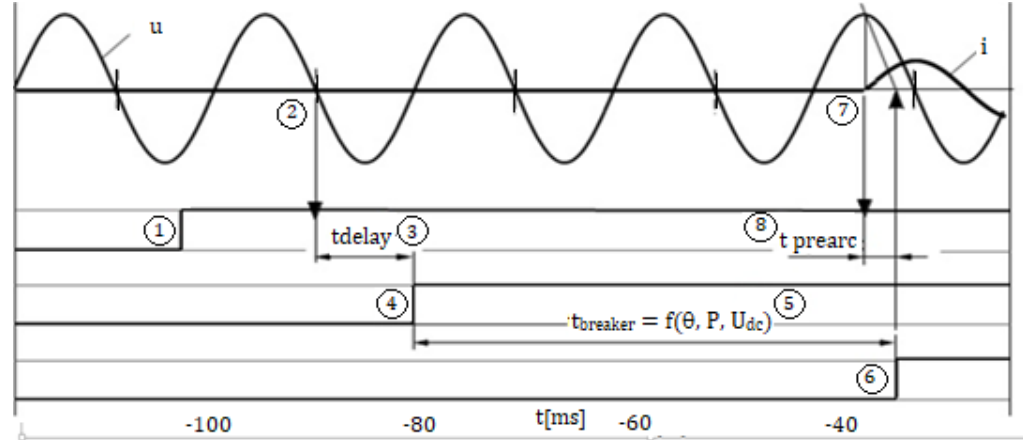
Figure 7. Connecting operation of circuit breaker with a control system: 1—connected command, 2—identify the zero point of the voltage, 3—delay time, 4—command to the breaker connected coil, 5—connected time, 6—touch contacts; 7—beginning of current flow, 8—prearc time.